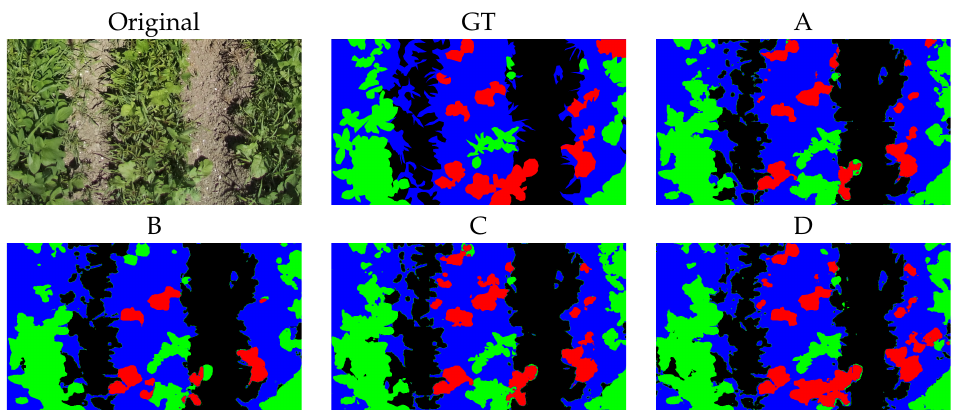
Figure 26. Results obtained from comparing semantic segmentation in the respective experiments with Soybeans.